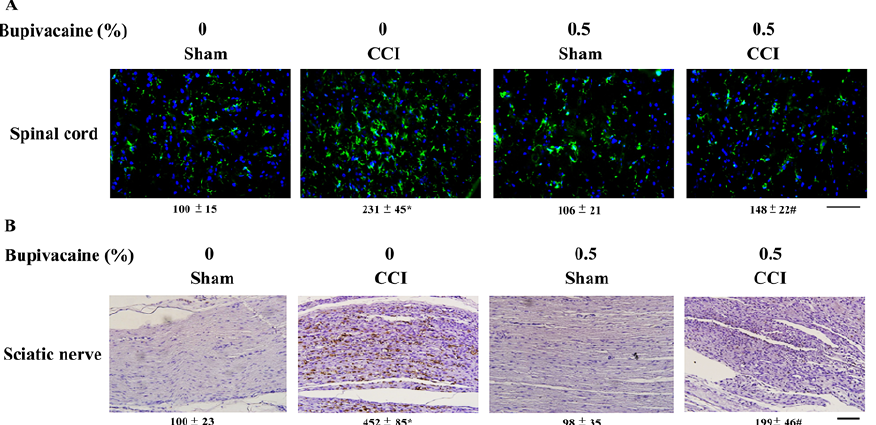
Figure 2. Bupivacaine alleviated microglia immunoreactivity in CCI rats. Rats were intrathecally injected with the indicated concentrations of bupivacaine (0 and 0.5%, diluted in saline) for 30 min prior to being subjected to sham and CCI operation. Seven days later, frozen sections of ipsilateral spinal cords (L4–L6) ( A ) and paraffin sections of ipsilateral sciatic nerves ( B ) were prepared and sub- jected to immunohistochemistry with antibodies recognizing CD68. Scale bar: 50 µ m. Representative photomicrographs show immunoreactivity visualized with FITC fluorescence (( A ), counterstained with Hoechst 33342) and diaminobenzidine (( B ), counterstained with hematoxylin), respectively. Relative intensity of immunoreactivity was measured and depicted under photomicrographs (%). * p < 0.05 vs. sham/saline group and # p < 0.05 vs. CCI/saline group, n = 3.